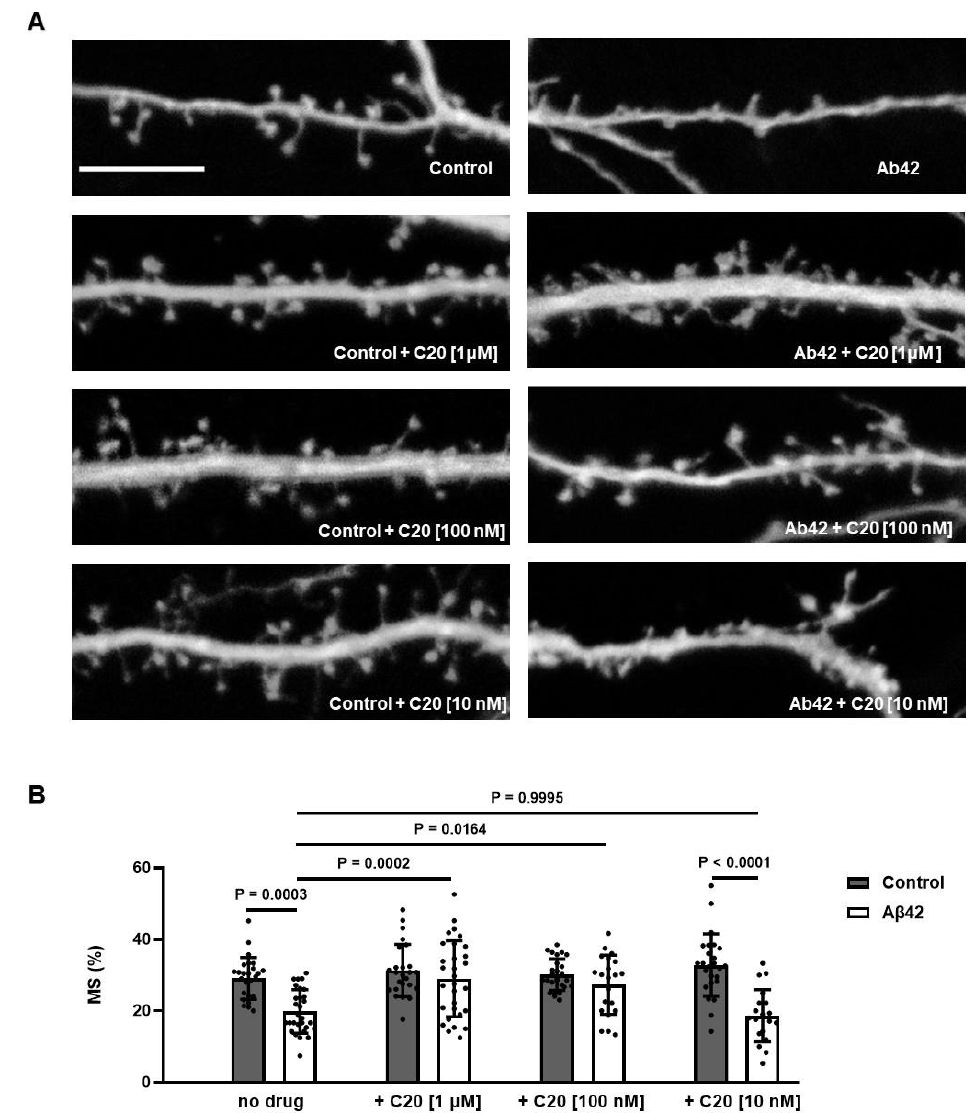
Figure 2. C20 recovers mushroom spine percentage in amyloid-induced synaptotoxic conditions in vitro. ( A ) Representative images of TD-tomato-expressing neurites and dendritic spines. Images for control (Control) cultures and oligomeric amyloid- β exposed cultures (A β 42) are shown as indicated. C20 was added at the concentration of 10 nM, 100 nM and 1 µ M as indicated. Scale bar 10 µ m. ( B ) The average percentages of mushroom spines (MS%) in each experimental condition are presented as mean ± SEM (n = 20–30 neurons for each group from three independent experiments). Filled bars correspond to untreated hippocampal cultures (Control). A β 42 treated hippocampal cultures (A β 42) are shown as open bars. Sample distributions were assessed for normality (Shapiro–Wilk test) and homogeneity (Bartlett’s test). Statistical analysis was performed using two-way ANOVA following Tukey’s multiple comparisons test. ns: not-significant, P values are indicated on the panel ( B